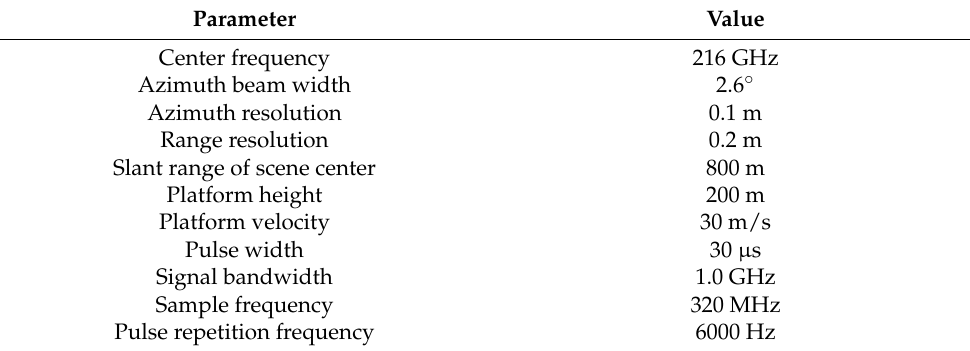
Table 1. System parameters of the